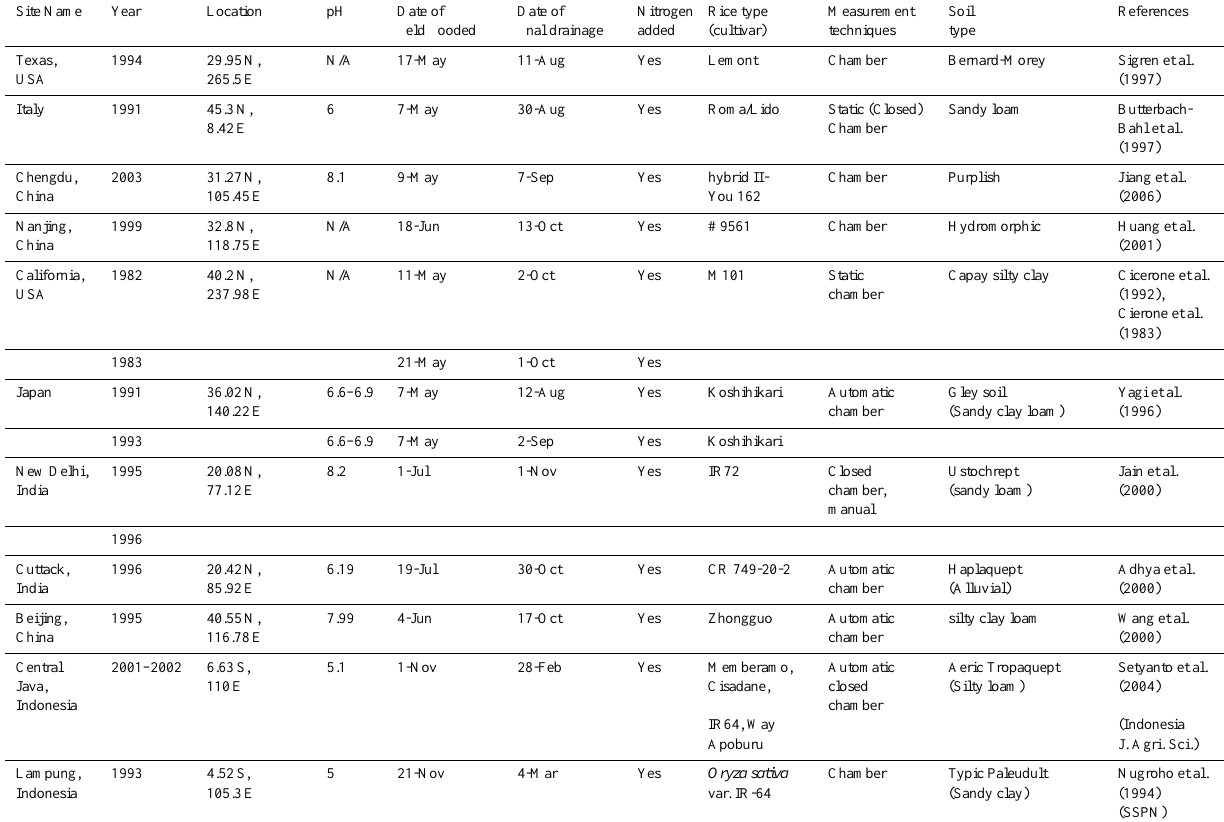
Table 1. Site descriptions for rice paddy